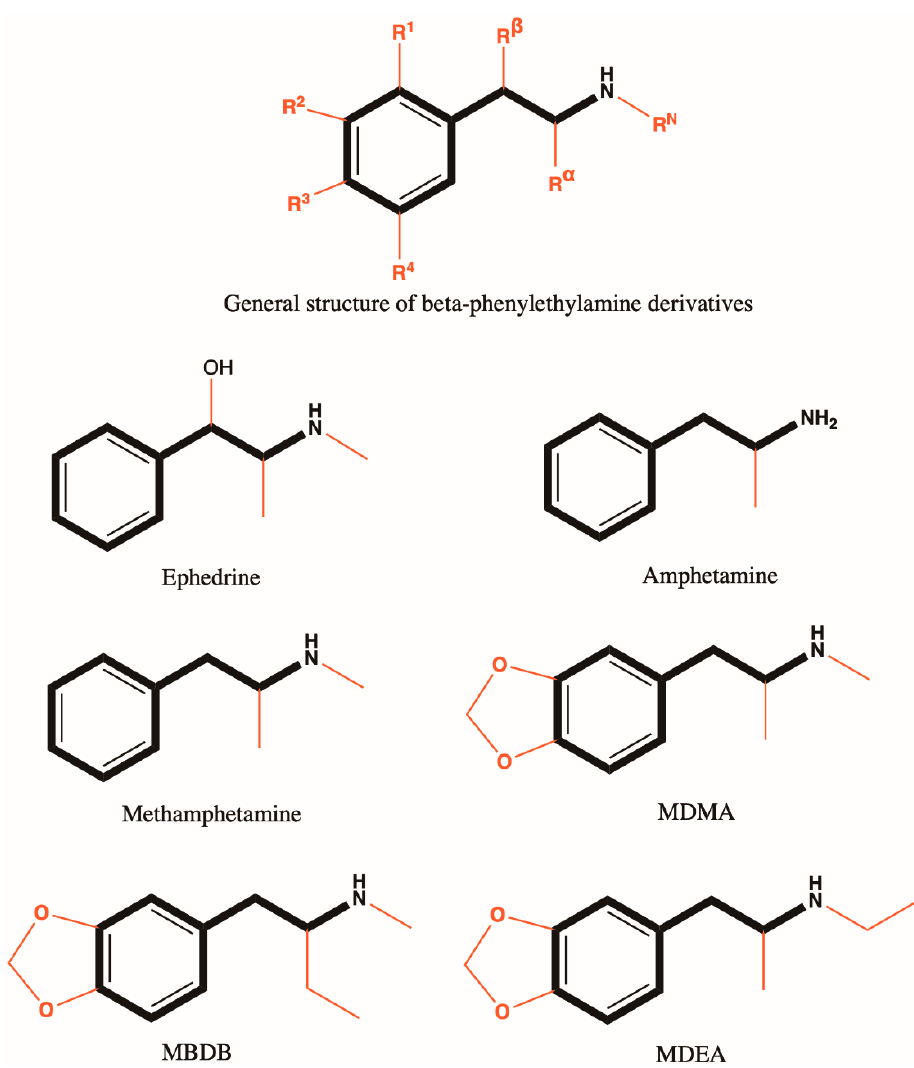
Figure 2. Chemical structures of amphetamine derivatives.